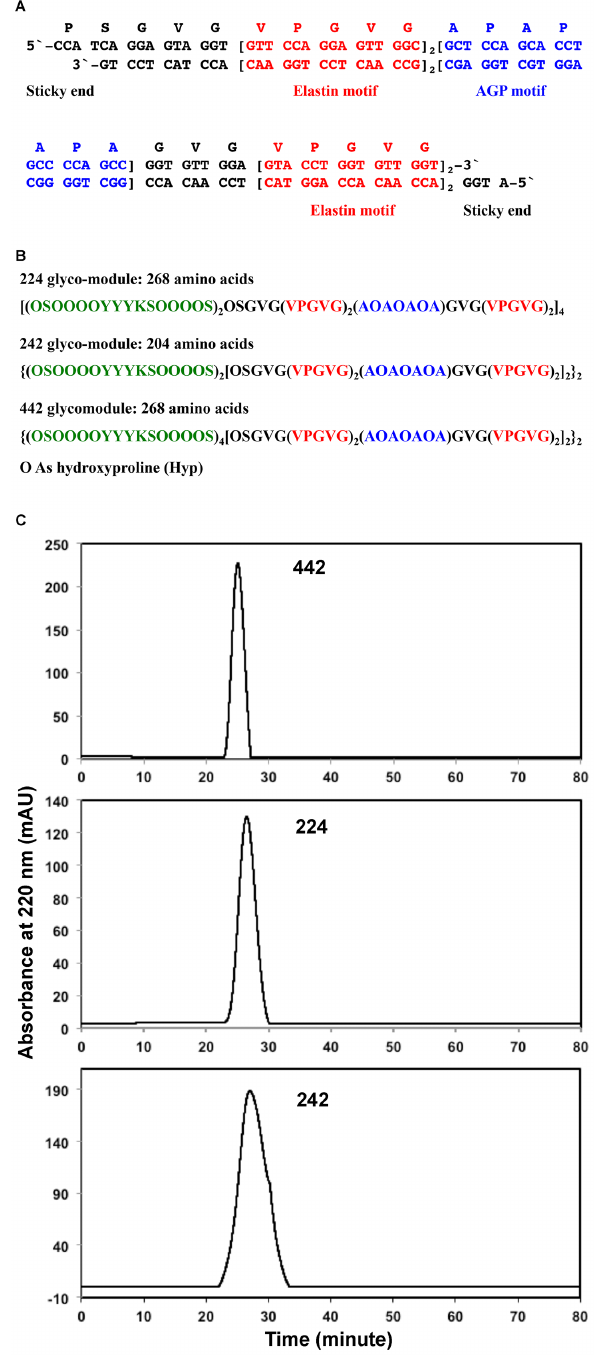
Fig. 1. Designed nucleotides (A), deduced protein sequences (B), and purification of 442 glycomodule (C). A. Designed nucleotides encode four repeats of human elastin motifs separated by an AGP motif Ala-Pro- Ala-Pro-Ala-Pro-Ala, with two sticky ends for cloning. B. Predicted polypeptide sequence of each glycomodule based on previous work on synthetic gene products. However, based on amino acid composition analysis, Pro residues in the elastin motifs were also hydroxylated. C. Size exclusion chromatograms of the